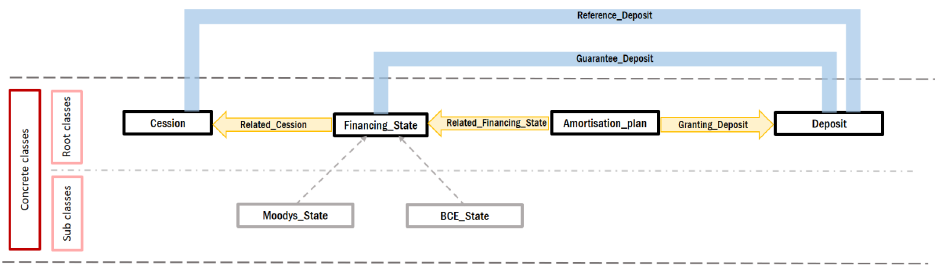
Figure 7. Graphical representation of the virtual relationships defined for the running